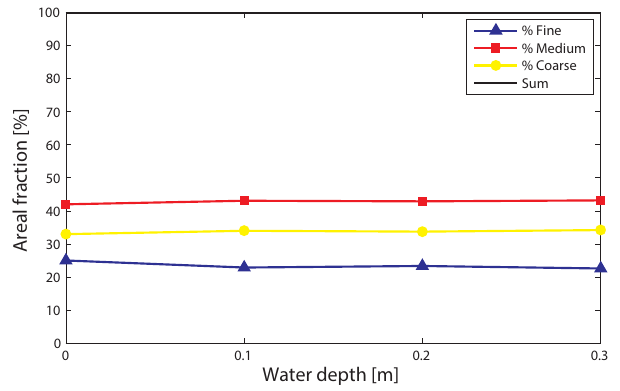
Figure 11. Origin of white pixels in images of an unsubmerged bed; left: original images; right: binary image of the segmented image for the colour blue; at the top: images for an unsubmerged bed; at the bottom: images for a submerged bed. The extra white pixels in the unsubmerged pictures, indicated with blue circles, are due to reflections of water